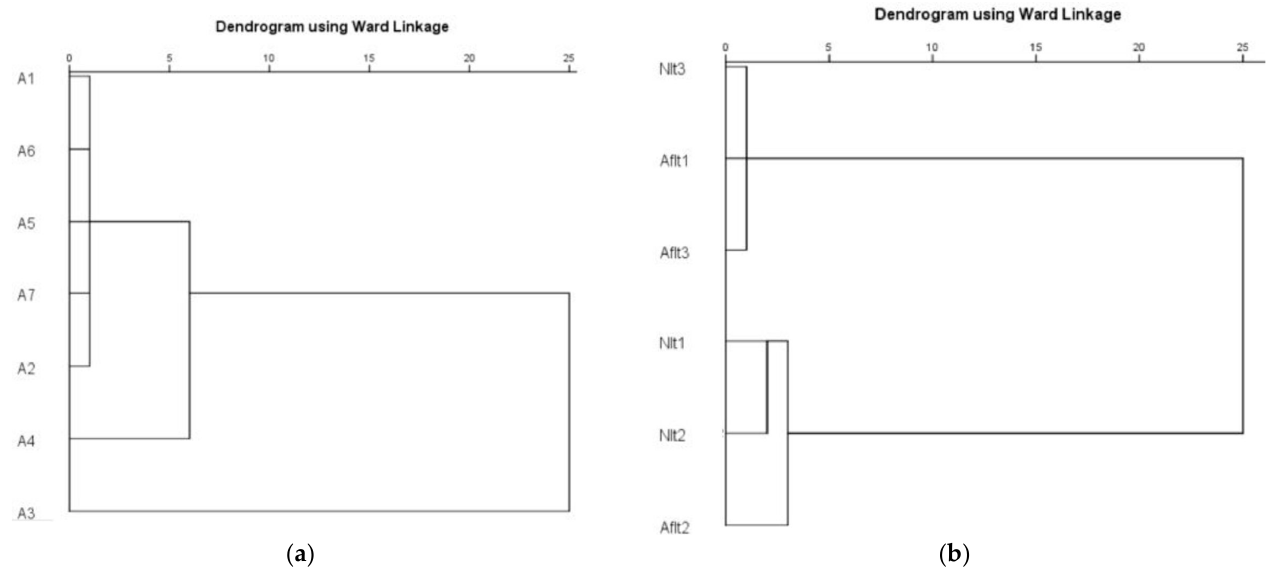
Figure 9. Hierarchical cluster analyses of rhizospherae microbial communities in garden peas. ( a ) Analysis by trophic groups of microorganisms. A1: Micromycetes; A2: Actinomycetes; A3: Am-